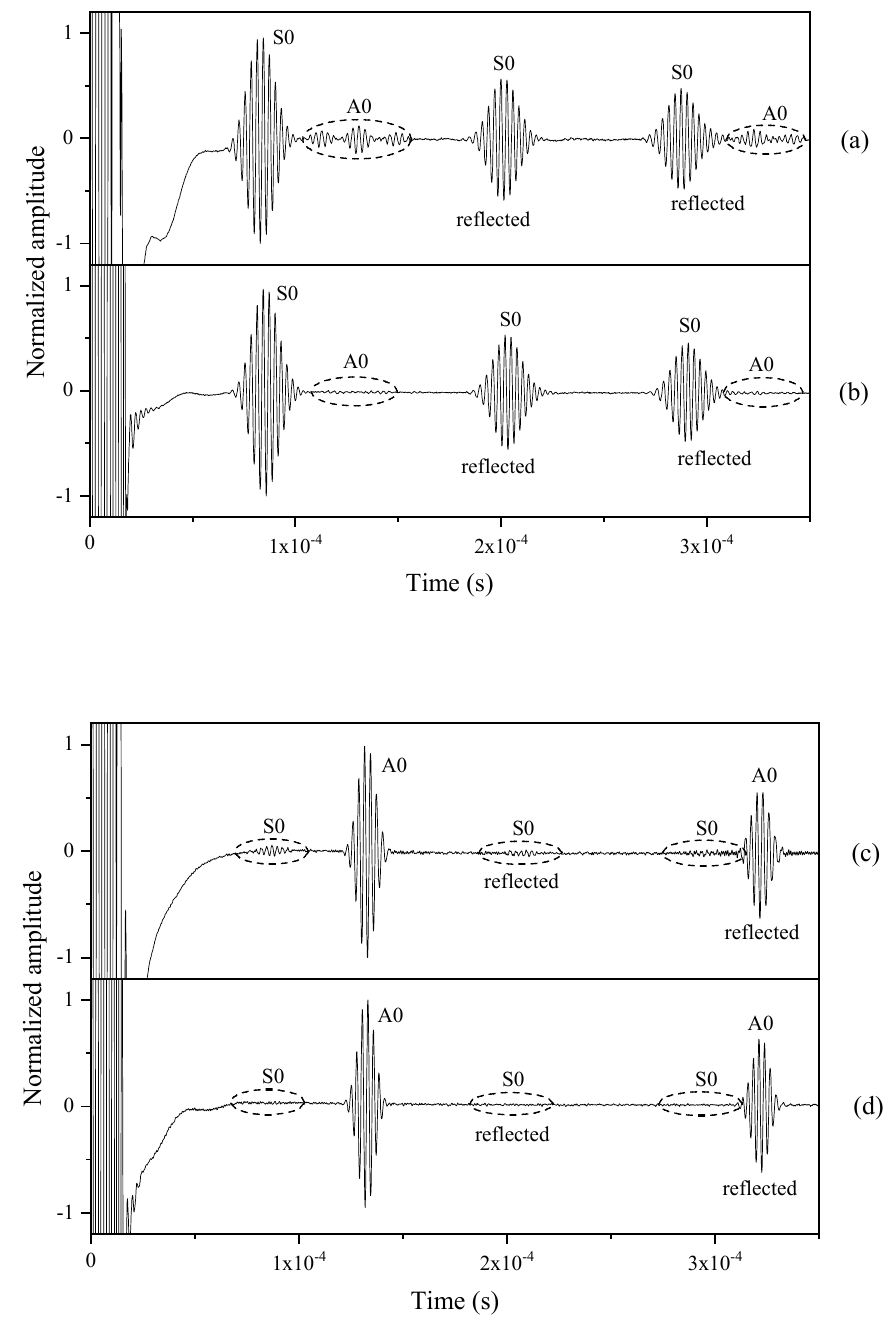
Figure 8. Results of the experiment. The collected Lamb wave signals, S0 mode, generated by ( a ) traditional EMAT and ( b ) paired NB-EMAT; A0 mode, generated by ( c ) traditional EMAT and ( d ) paired PB-EMAT. The results of simulations and experiments verify that the paired structure